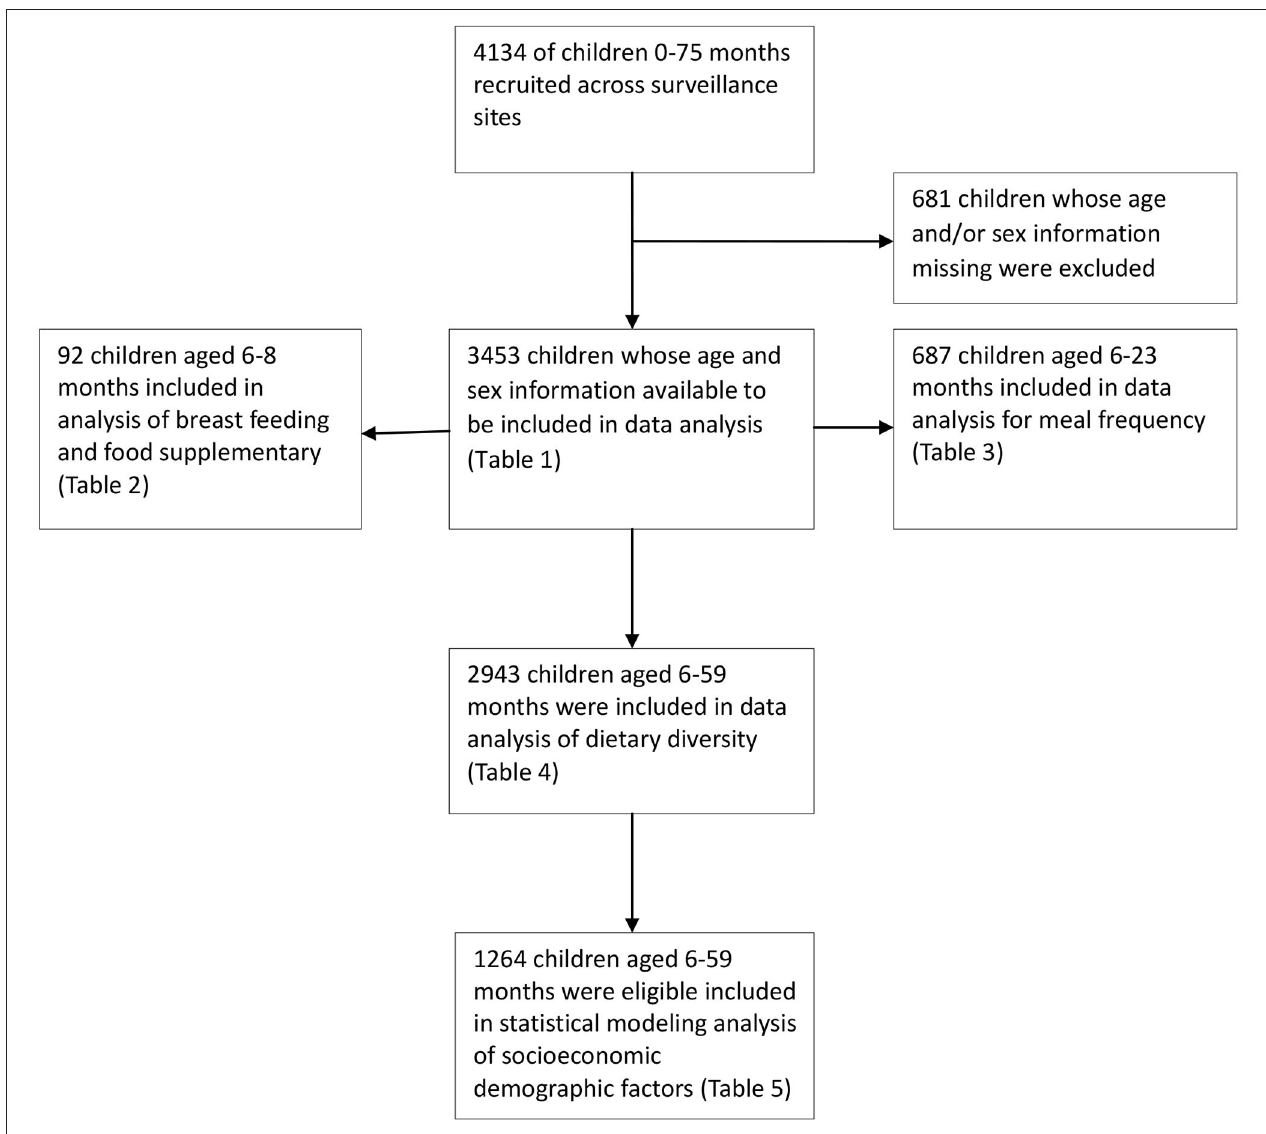
FIGURE 3 | Flow diagram of child participation and selection for data analysis, PNGIMR’s CHESS,